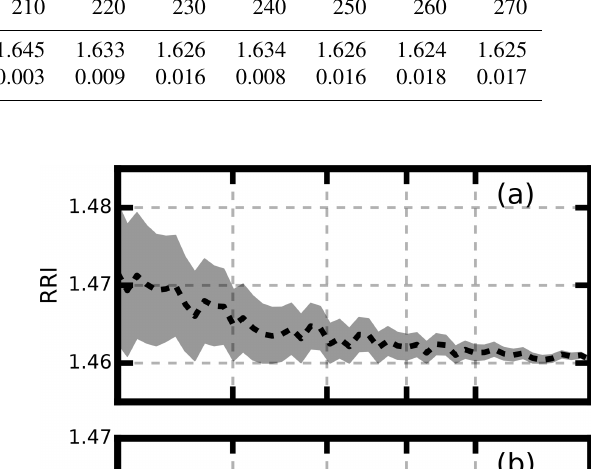
value 0.024 is used for further